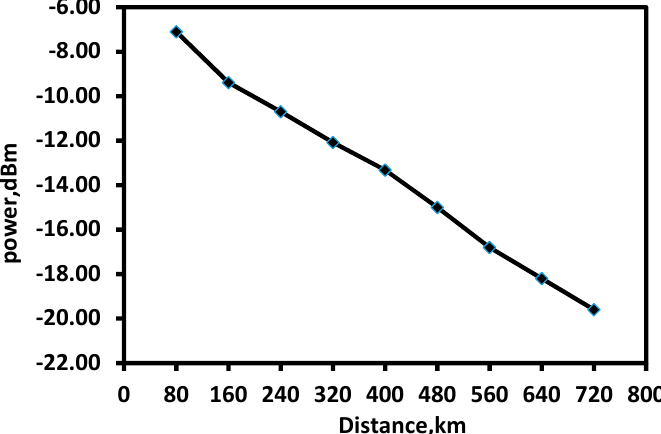
Figure 6. Received optical power vs. transmission distance for 9.69-Gb/s optical Fast-OFDM without (W/O) using NLE.